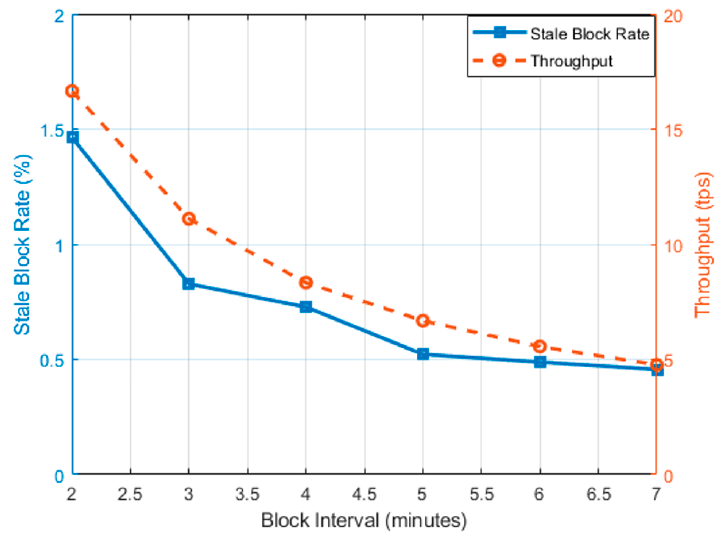
Figure 6. Effect of block interval 𝜏 on stale block rate and throughput.